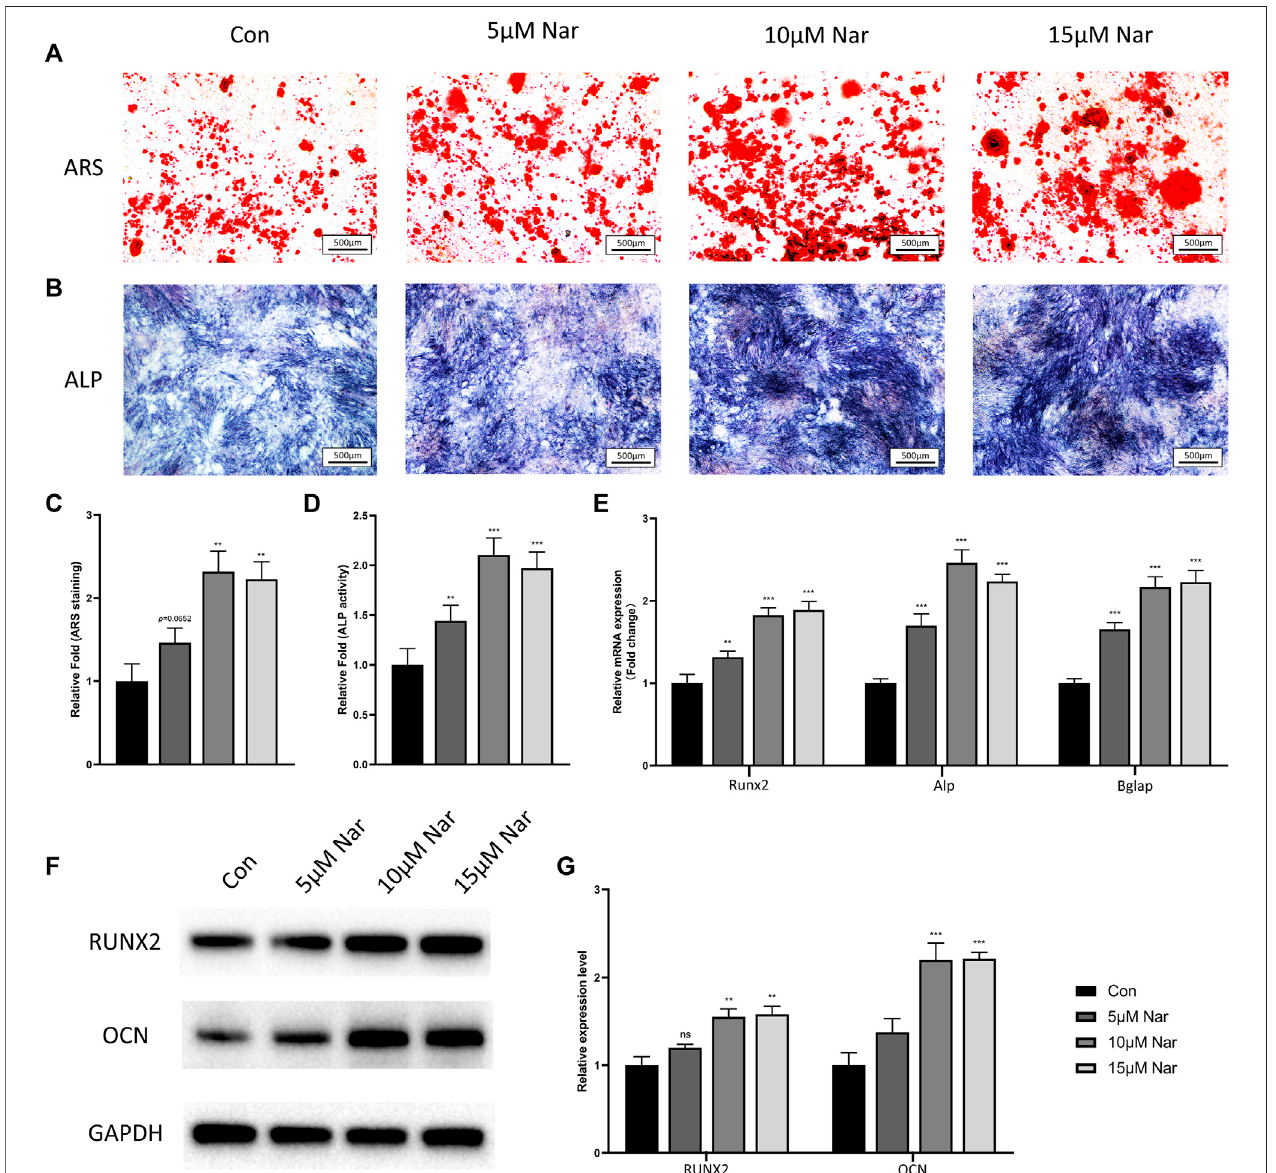
FIGURE 1 | Naringenin promotes osteogenic differentiation of BMSCs. (A,C) ARS staining and its quanti fi cation. (B,D) ALP staining and its quanti fi cation. (E) TranscriptlevelsofosteoblastmarkersRunt-relatedtranscriptionfactor2(Runx2),alkalinephosphatase(Alp),andbonegamma-carboxyglutamateprotein(Bglap). (F,G) Westernblot and optical density analysis ofRUNX2 and OCN with Gapdh as reference. n = 4 per group. Dataare expressed as mean ±SD. p p < 0.05; pp p < 0.01; ppp p < 0.001. p compared with con group.